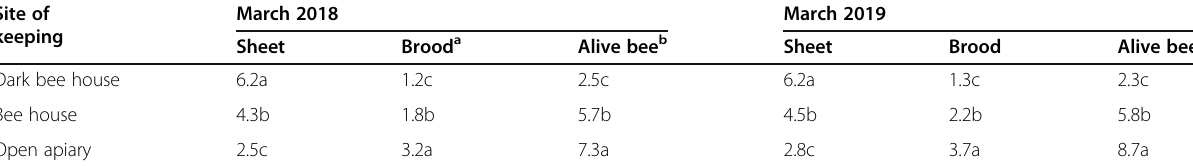
Table 1 Effect of keeping-bee hives in a dark bee house compared with keeping in bee house with windows and in open apiary on the average number of fallen Varroa mites on white card board sheets as well as on broods and alive bees, during March of 2018 and 2019 at Dakahlia governorate, Egypt Site of